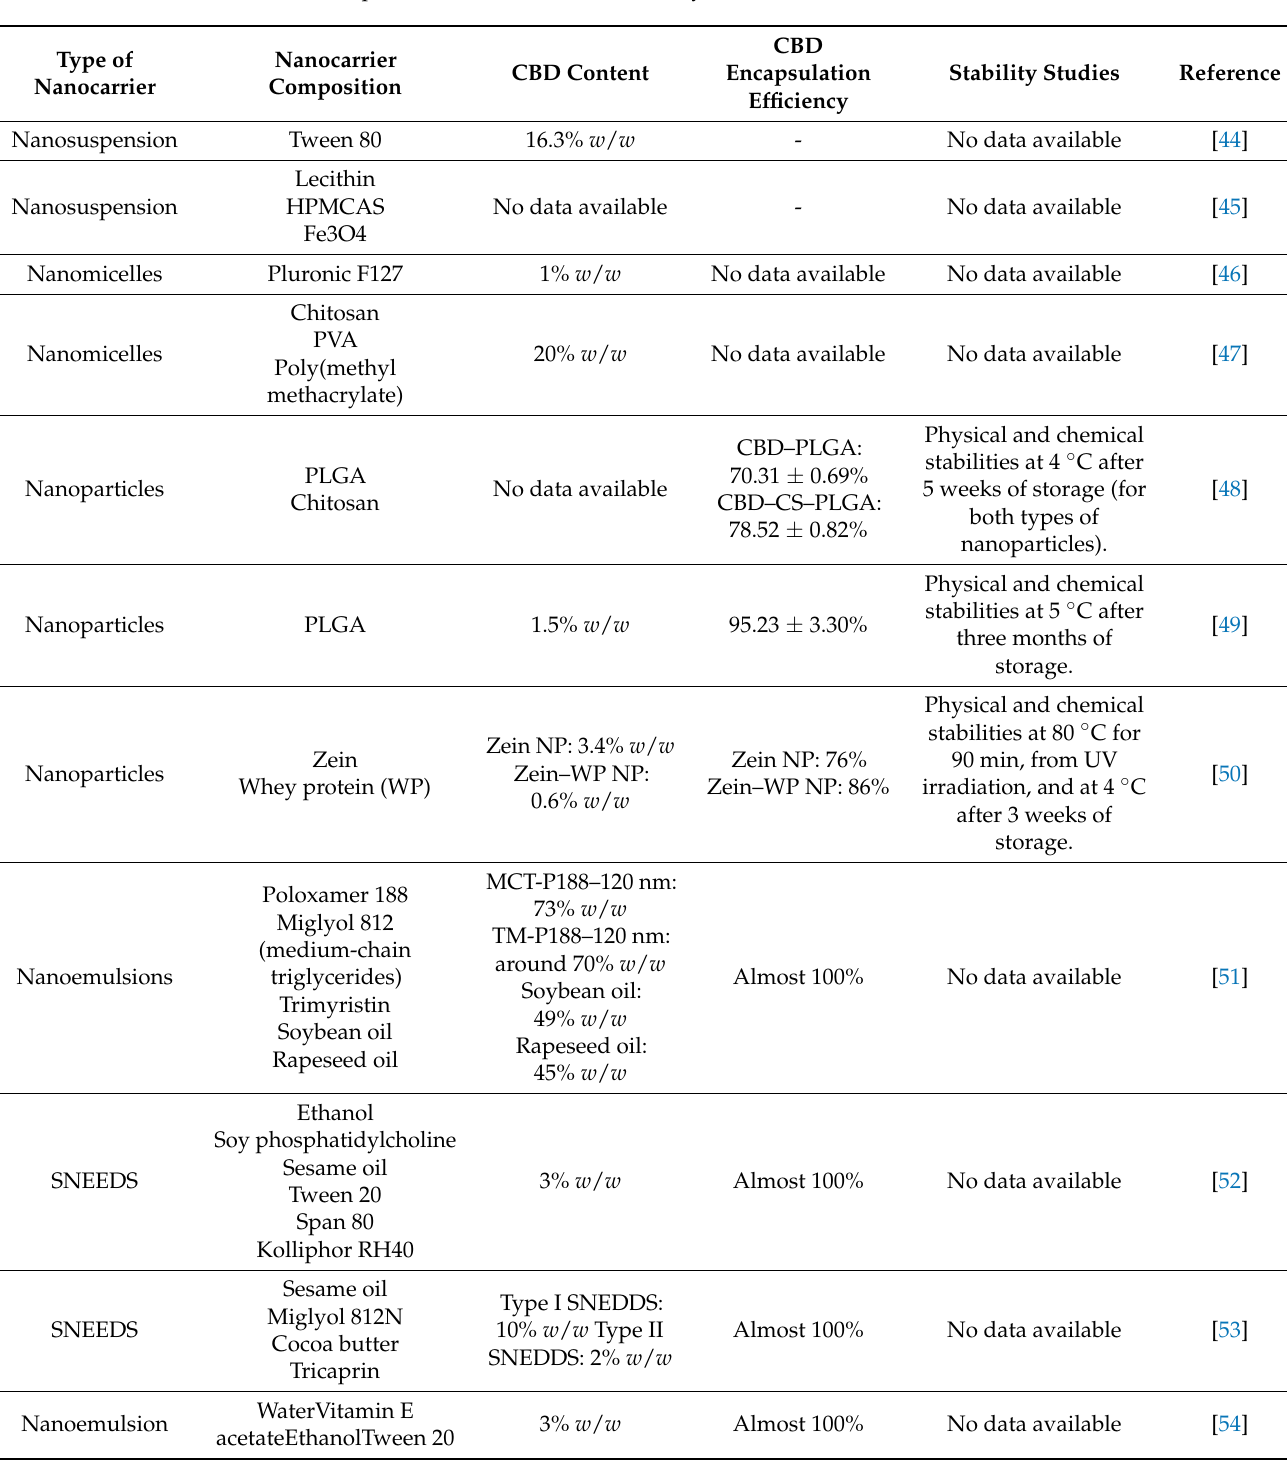
Table 1. Developed nanocarriers loaded with CBD and their compositions, CBD contents, CBD encapsulation efficiencies, and stability